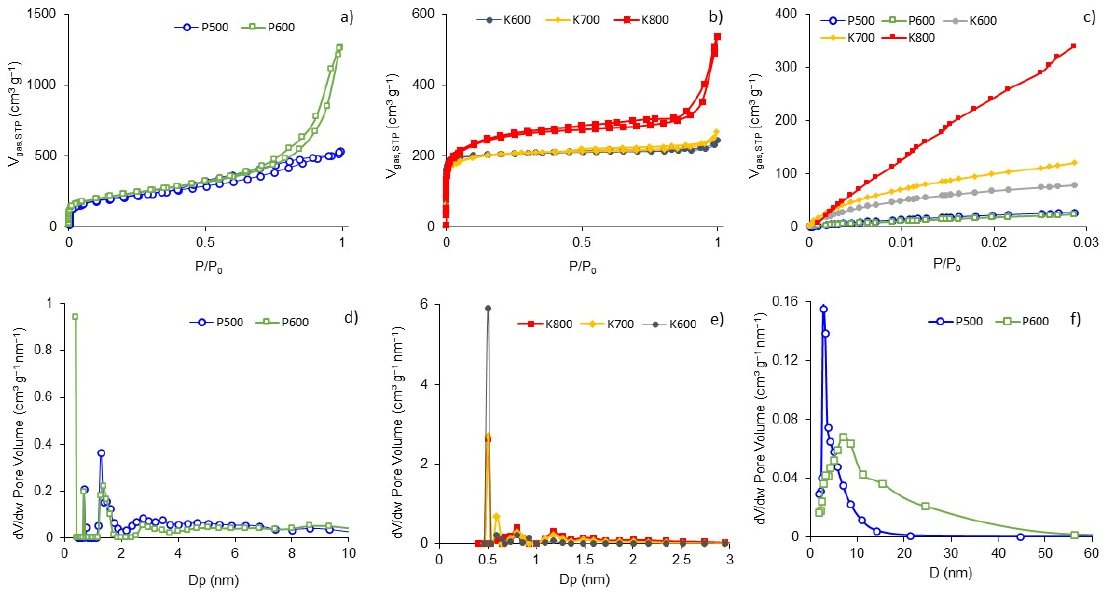
Figure 4. N 2 isotherms at 77 K for ( a ) BNCA-P and ( b ) BNCA-K; ( c ) CO 2 isotherms at 273 K, with pore size distribution by DFT for ( d ) BNCA-P and ( e ) BNCA-K, and ( f ) pore size distribution by BJH for BNCA-P.